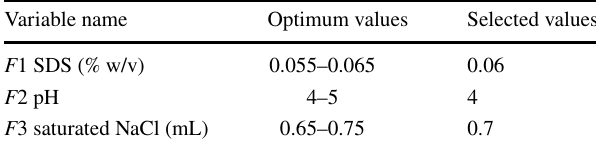
Fig. 1 Response surface of full quadratic model between absorbance and the three variables: concentration of SDS amount (F1), pH (F2) and added volume of saturated solution of NaCl (F3): a response surface plot for the effect of concentra- tion of SDS amount and added volume of saturated solution of NaCl on the absorbance, when pH was fixed at 5.5, b response surface plot for the effect of pH and concentration of SDS amount, when saturated NaCl was fixed at 0.55 ml, c response surface plot for the effect of added volume of saturated solu- tion of NaCl and concentration of SDS amount, when pH was fixed at 5.5